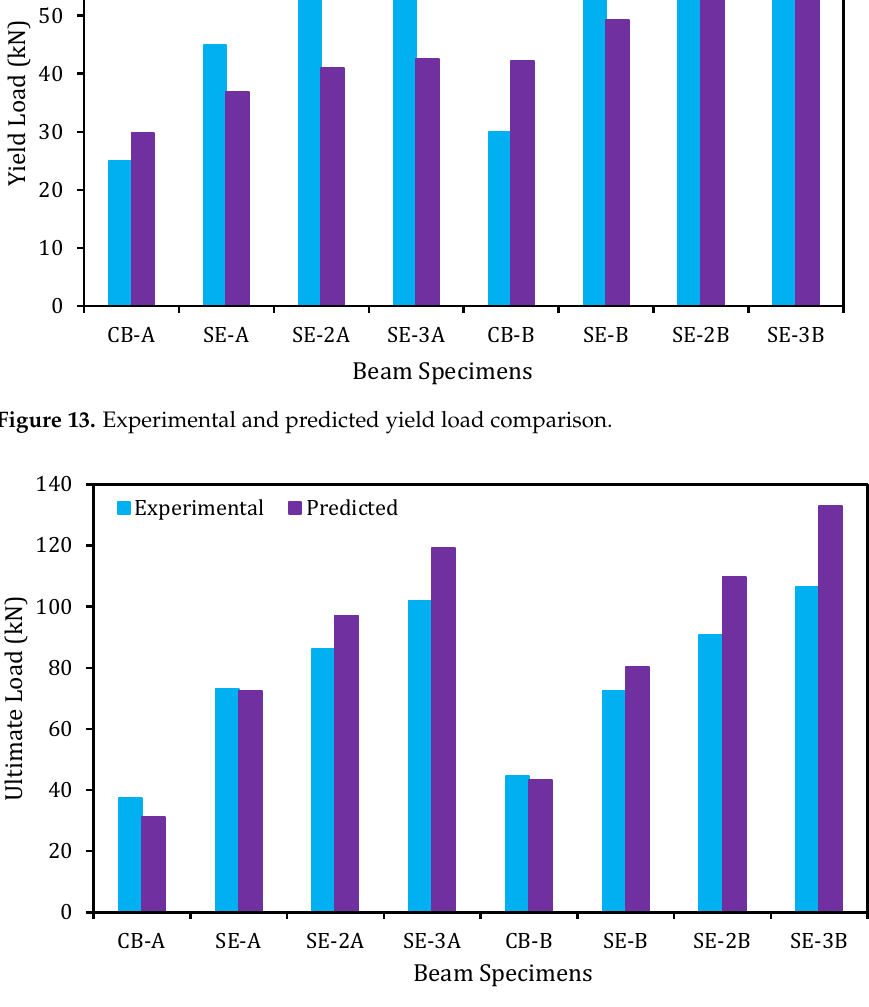
Figure 14. Experimental and predicted ultimate load comparison.